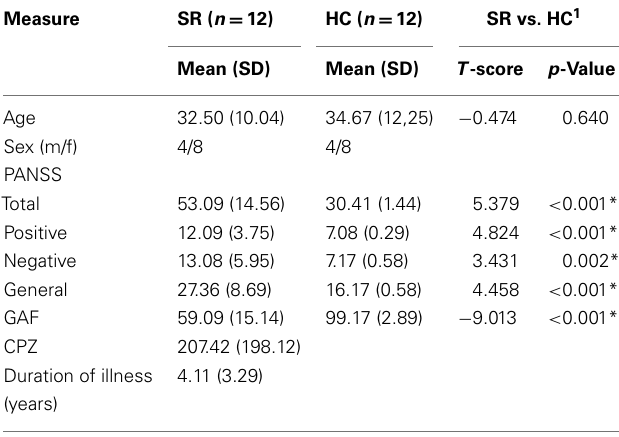
Table 1 | Demographic and clinical